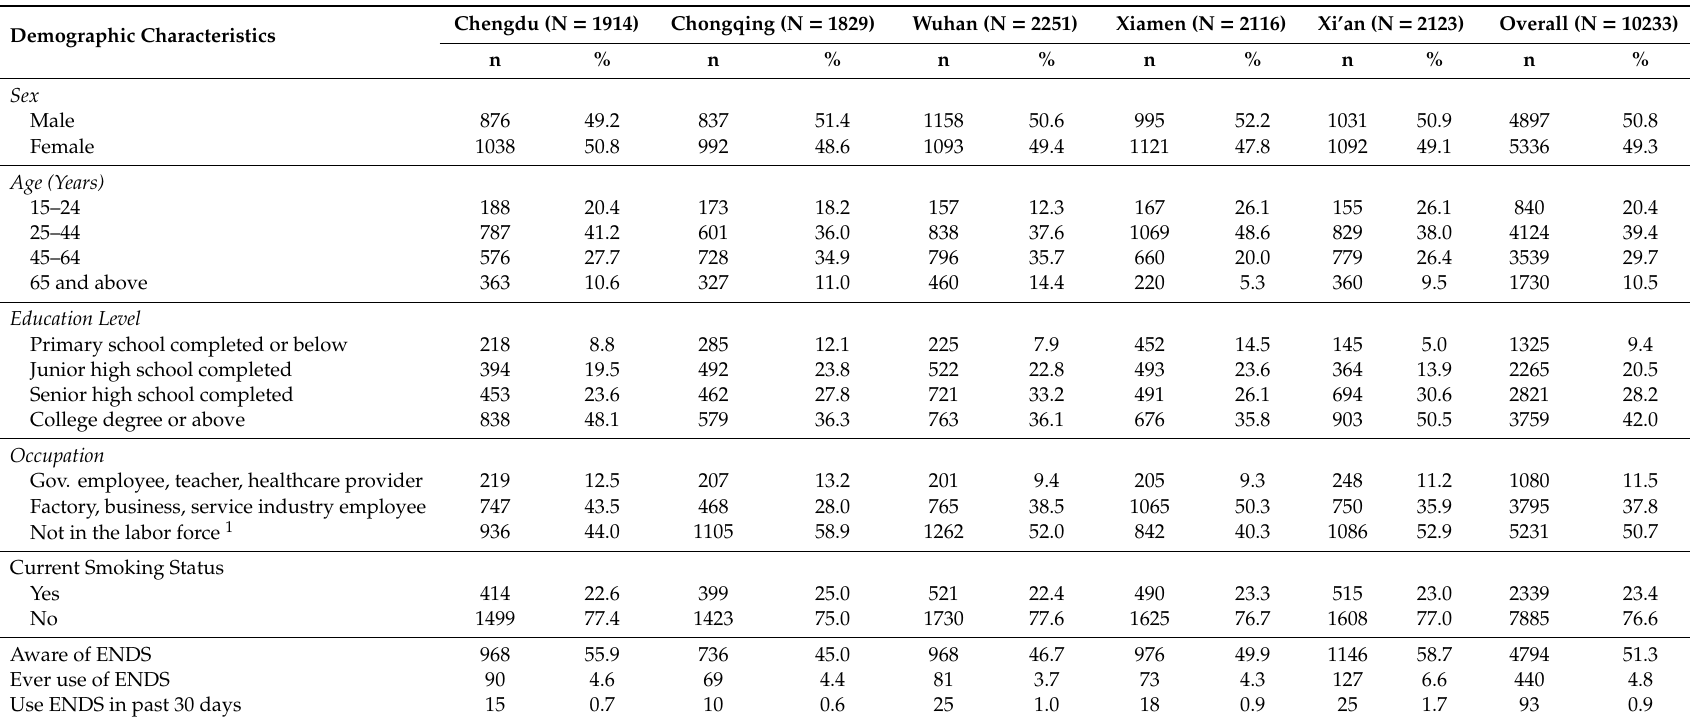
Table A1. Demographic characteristics among all adult residents–TQS,